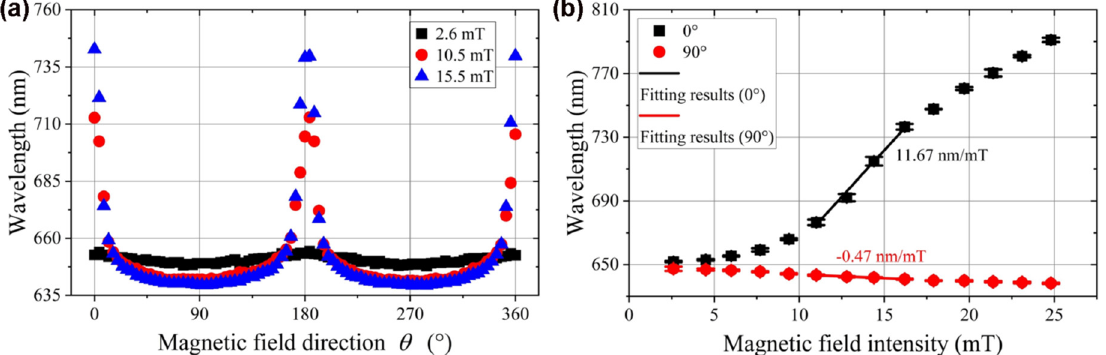
Figure 12: SPR dip wavelength as a function of external magnetic field direction ( 𝜃 ) at different intensities (a) and external magnetic field intensity ( B ) at 0 ◦ and 90 ◦ direction (b).